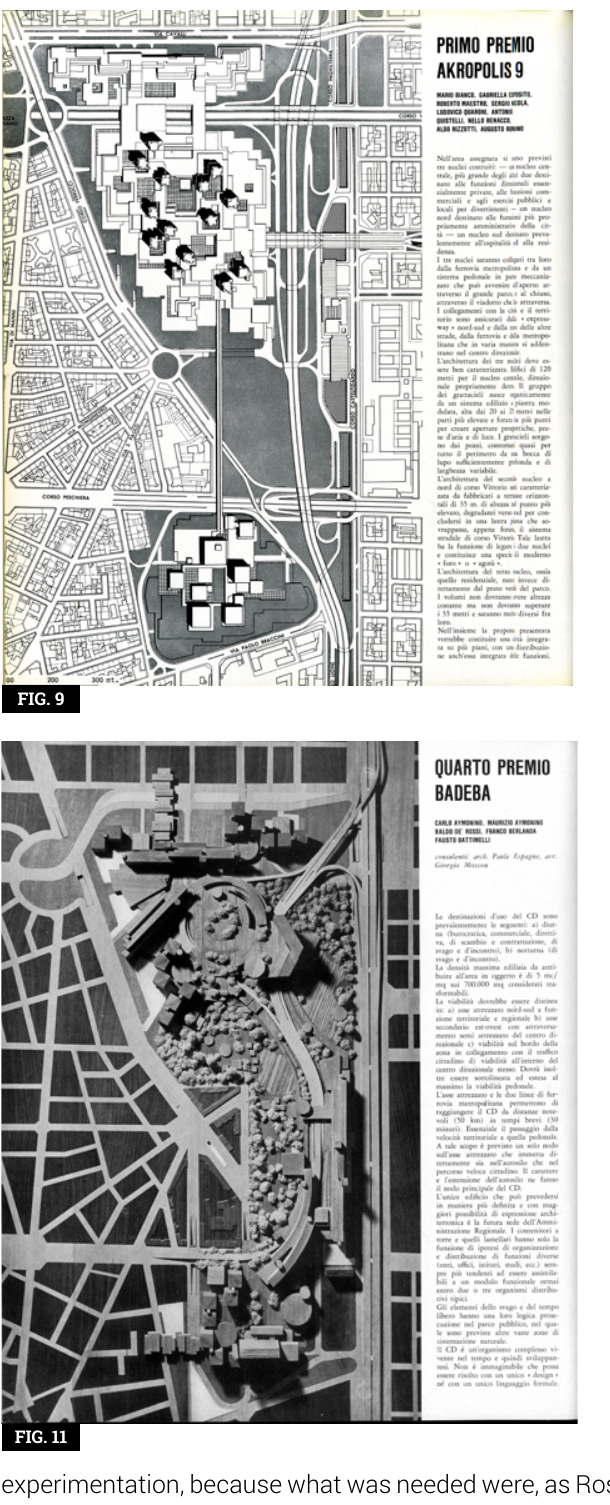
55. Rossi, ‘Nuovi problemi’.